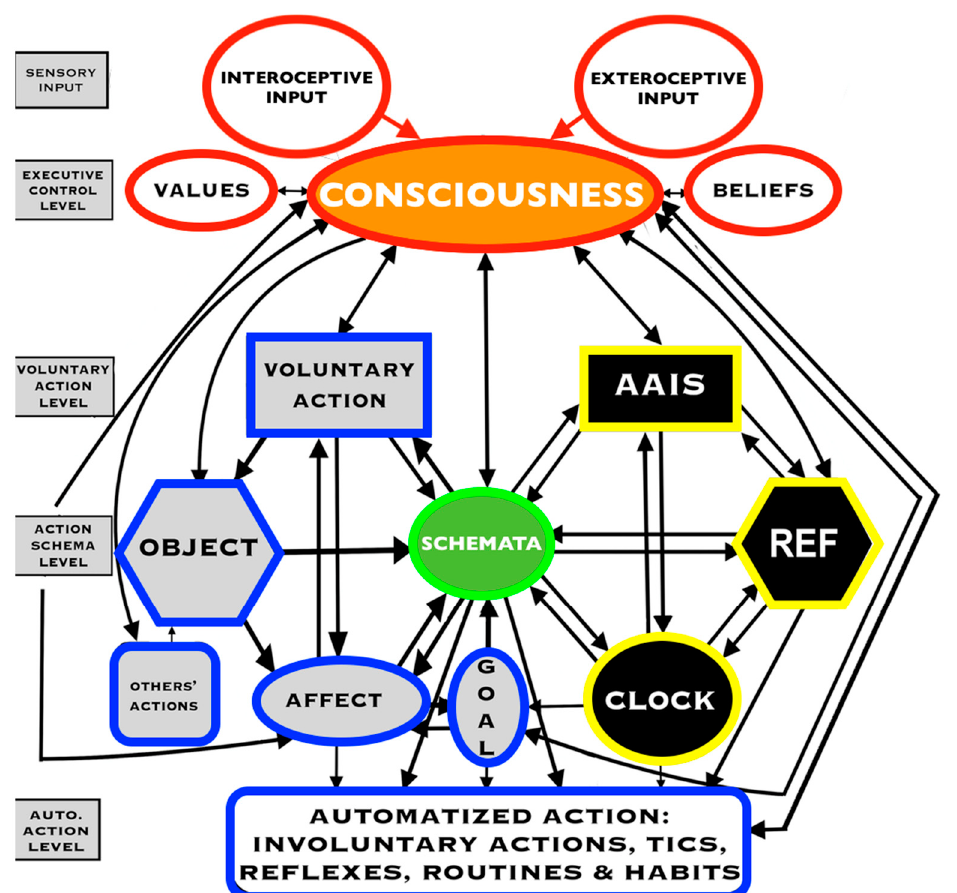
Figure 9. The behavior control system shown with five levels of organization and nine modular systems for the generation of action with consciousness at the executive level. The modules fall into three groups: (i) the ACT group of modules from Figure 7 (gray and blue); (ii) the REF (type II homeostasis), clock (circadian system), and AAIS (approach/avoidance/inhibition system) from Figure 8 (black and yellow) interconnecting with the ACT group via action schemata (green); (iii) the behavior control system/consciousness (red, white, and orange) includes modules for interoceptive and exteroceptive sensory input, beliefs, and values. Five levels of control are sensory input, executive control, voluntary behavior, the AAIS, action schemata, and REF, and the automatized action level. The structure of the affective system (not shown) is mediated by the limbic system, a lateral circuit passing through the hypothalamus regulating internal and hormonal processes, the cingulate cortex, the hippocampus, and amygdala.